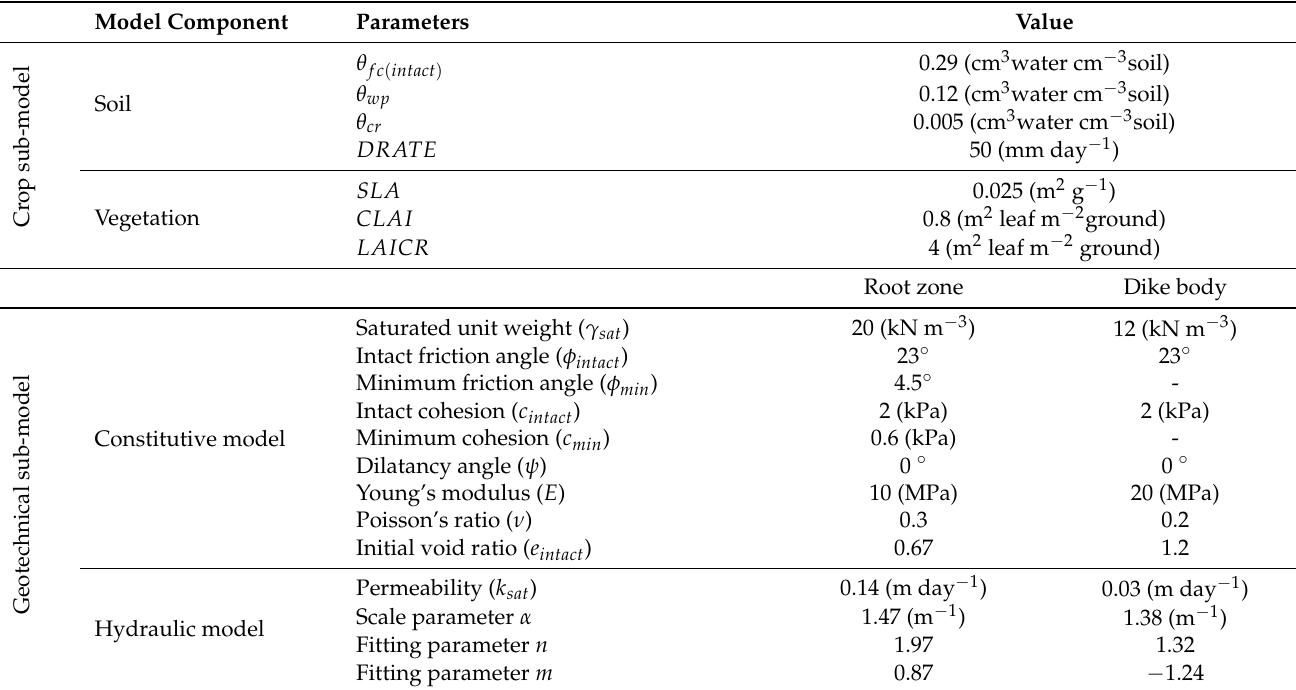
Figure 5. Daily values of inputs for the crop model from 2009 to 2019 ( a ) Precipitation; ( b ) Average temperature; ( c ) Average wind speed; ( d ) Radiation. Table 1. Input parameters for non-cracked soil in the integrated